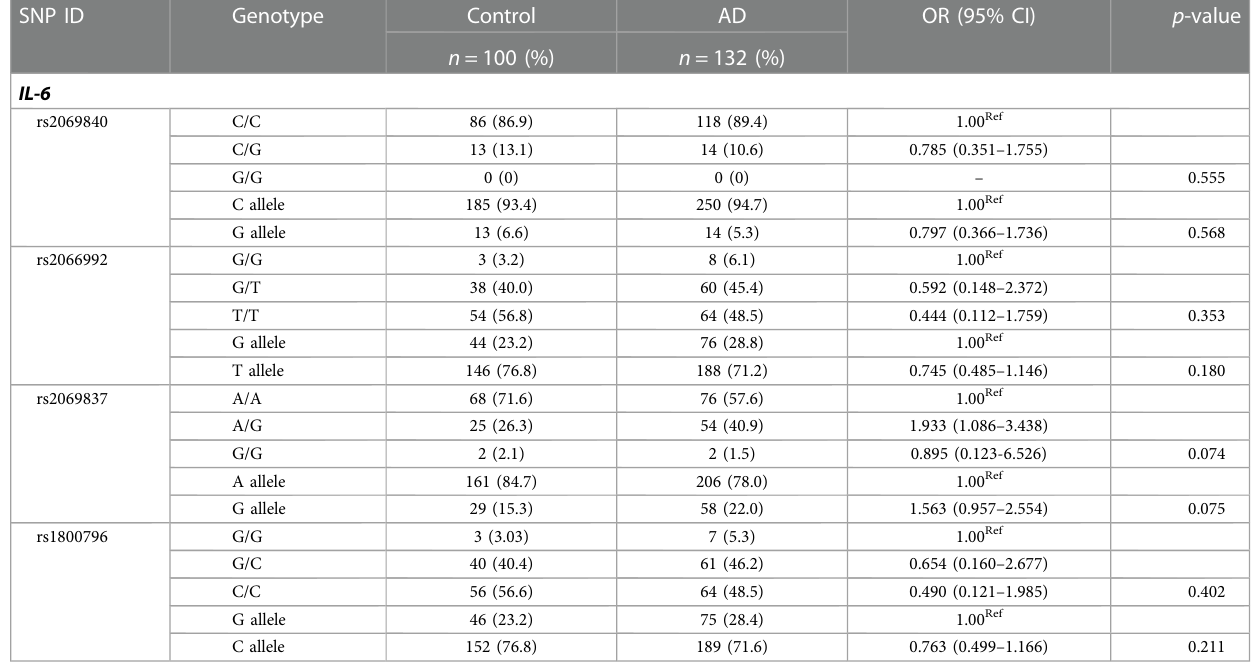
TABLE 3 Genotype and allele frequencies of IL-6 SNPs in AD patients and